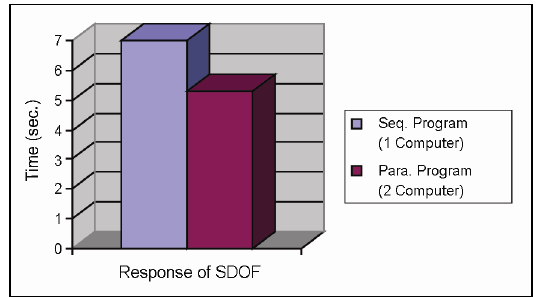
Fig. 10. Runtime comparison of sequential and parallel